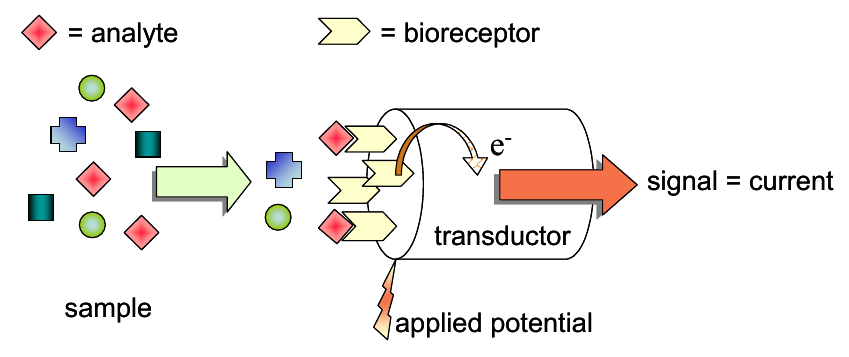
Figure 1. Scheme depicting the functional principles of an amperometric